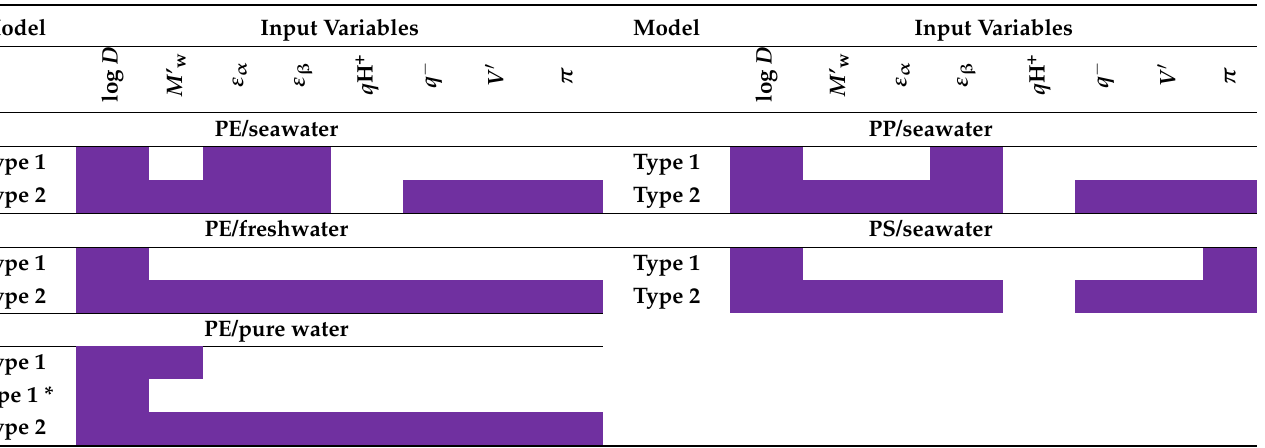
Table 1. Input variables, marked in purple, are used according to the input variable selection to predict log K d . Type 1 and type 1 * are the configurations used by Li et al. (2020) [17], and Type 2 is the configuration used in this research. Polyethylene (PE), polystyrene (PS), polypropylene (PP), and the eight variables reported used by Li et al. (2020) [17]: (i) n-octanol/water distribution coefficient at special pH condition (log D ); (ii) molecular mass ( M (cid:48) w ); covalent; (iii) acidity ( ε α ); and (iv) basicity ( ε β ); (v) most positive atomic charge on H atom ( q H + ); (vi) most negative atomic charge ( q − ); (vii) molecular volume ( V (cid:48) ); and (viii) molecular volume ( π